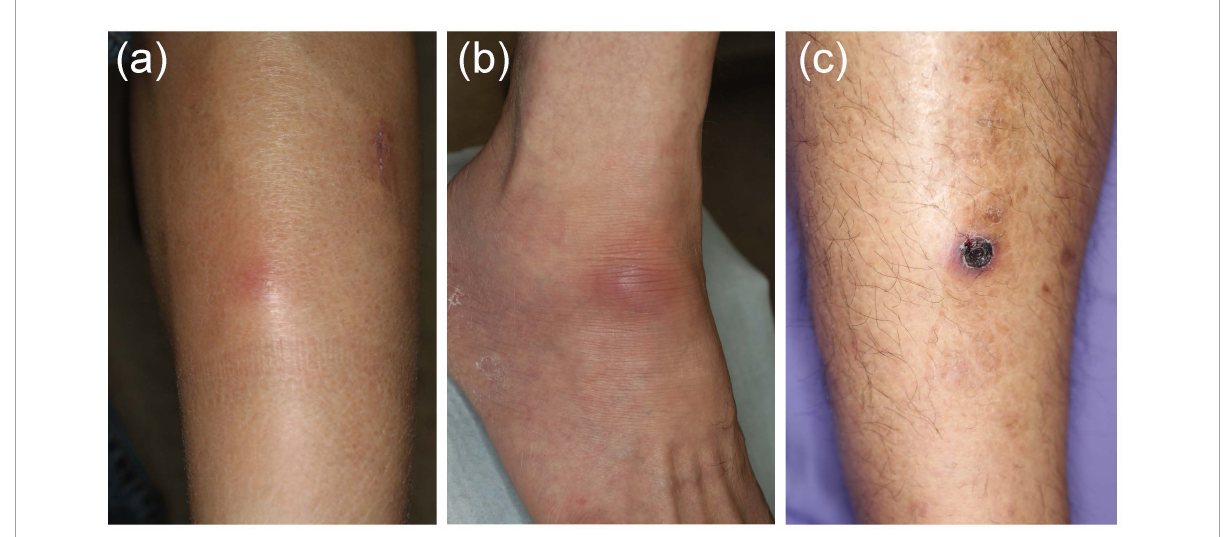
FIGURE2 Various skin lesions that may be present on the lower legs in Behçet’s disease (BD) patients. (a) Case 1, erythematous subcutaneous nodule on the leg. (b) Case 2, erythematous plaque on the ankle. (c) Case 3, crusted ulcer on the leg.